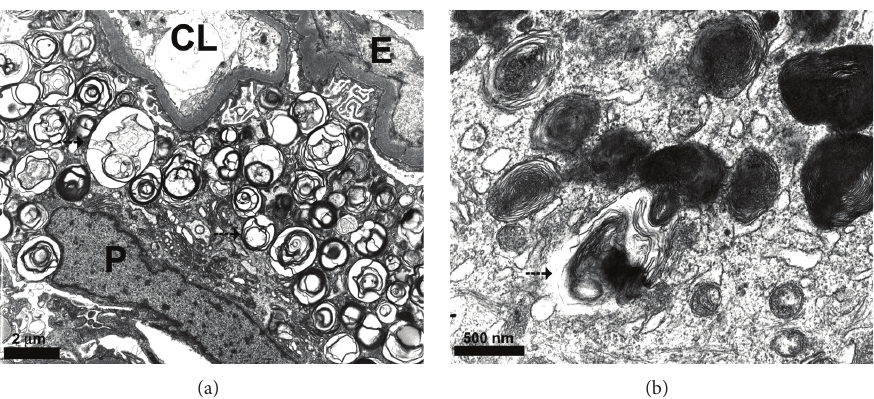
Figure 3: Electron microscopical changes in kidney (a) and native lung (b) biopsies. Glomerular podocytes (P) show extensive accumulation of “myeloid” and “zebroid” bodies (arrows) characteristics of Fabry diseases. However, capillary loops (CL) remain open, and endothelial cells (E) do not exhibit morphological changes. Ciliated pulmonary epithelial cells show an increase and accumulation of irregularly shaped inclusions in lysosomes and autophagosomes consistent with storage of sphingolipids